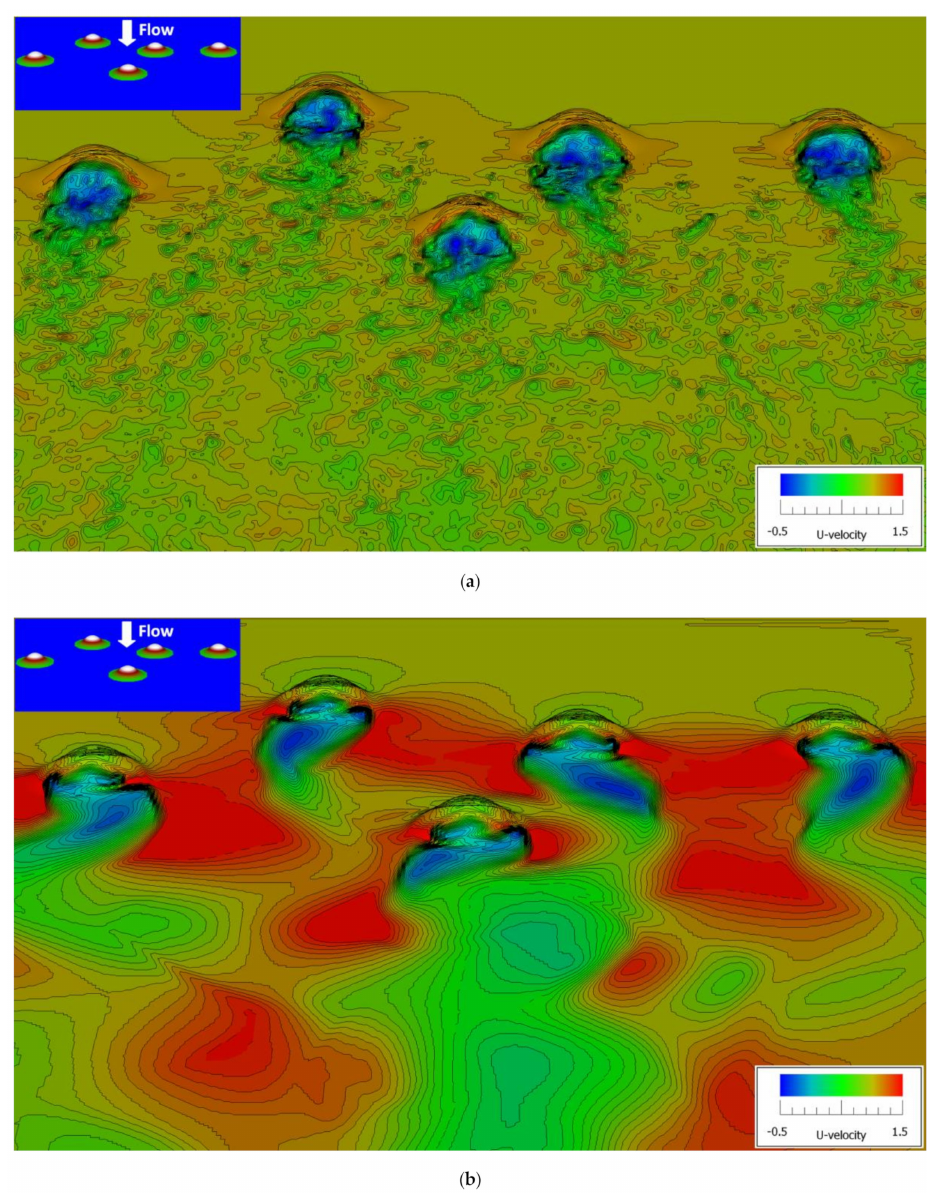
Figure 1. Comparison of neutral and stable stratified flow patterns for an instantaneous flow field in the case of steep hills. ( a ) Froude number—Fr = 1000 (neutral flow); ( b ) Fr = 0.1 (stable stratified